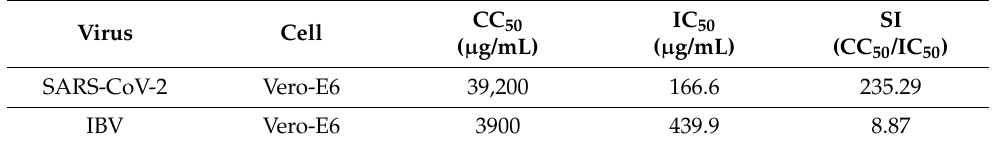
Table 1. CC 50 , IC 50 , and SI of